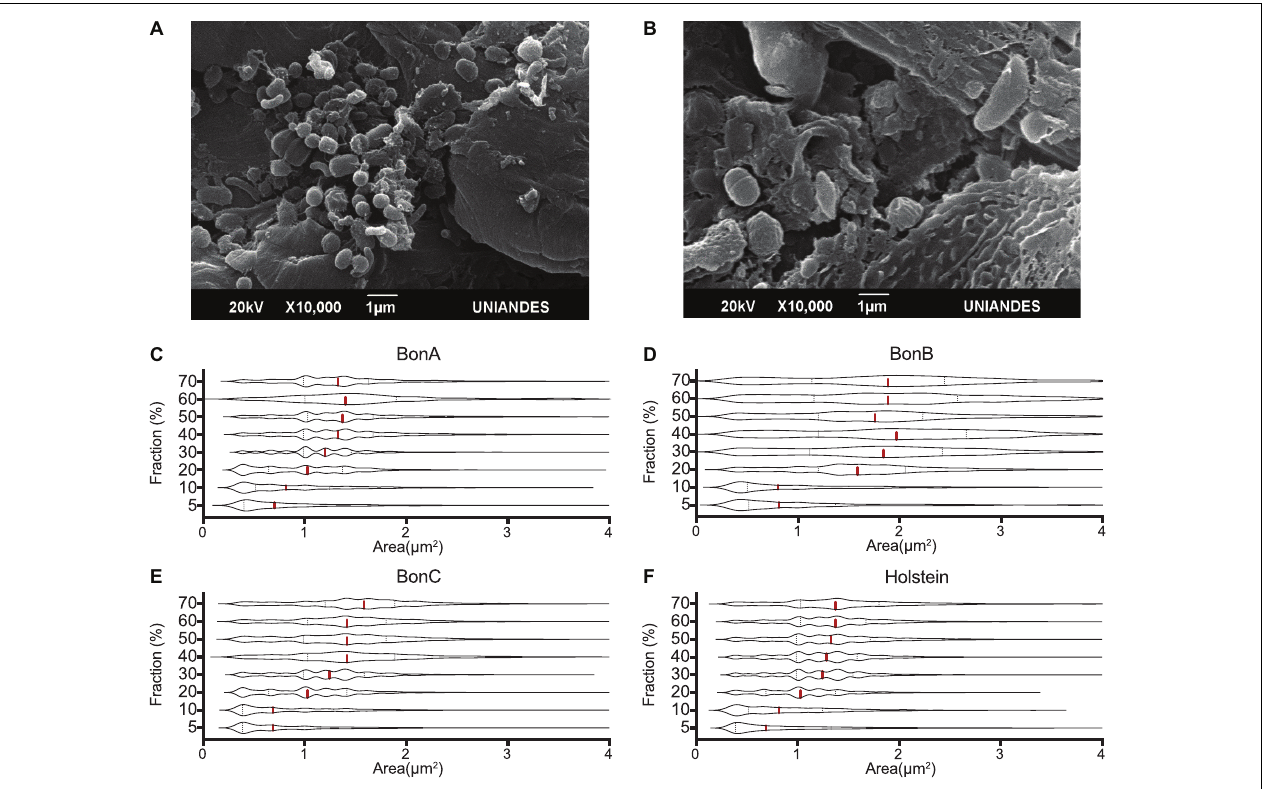
FIGURE 1 | Cell size distribution of rumen microorganisms retained by the different sucrose fractions. The transmission electron microscope images show the differences in the size of microorganisms present in the (A) 20% and (B) 70% sucrose fractions. Violin plots represent the distribution of cells’ area quantified by confocal microscopy, five confocal microscopy microphotographs were analyzed for each gradient and animal. The panels show the distributions of the 70, 60, 50, 40, 30, 20, 10, and 5% fractions, for the animals (C) BON-A, (D) BON-B, (E) BON-C and (F)